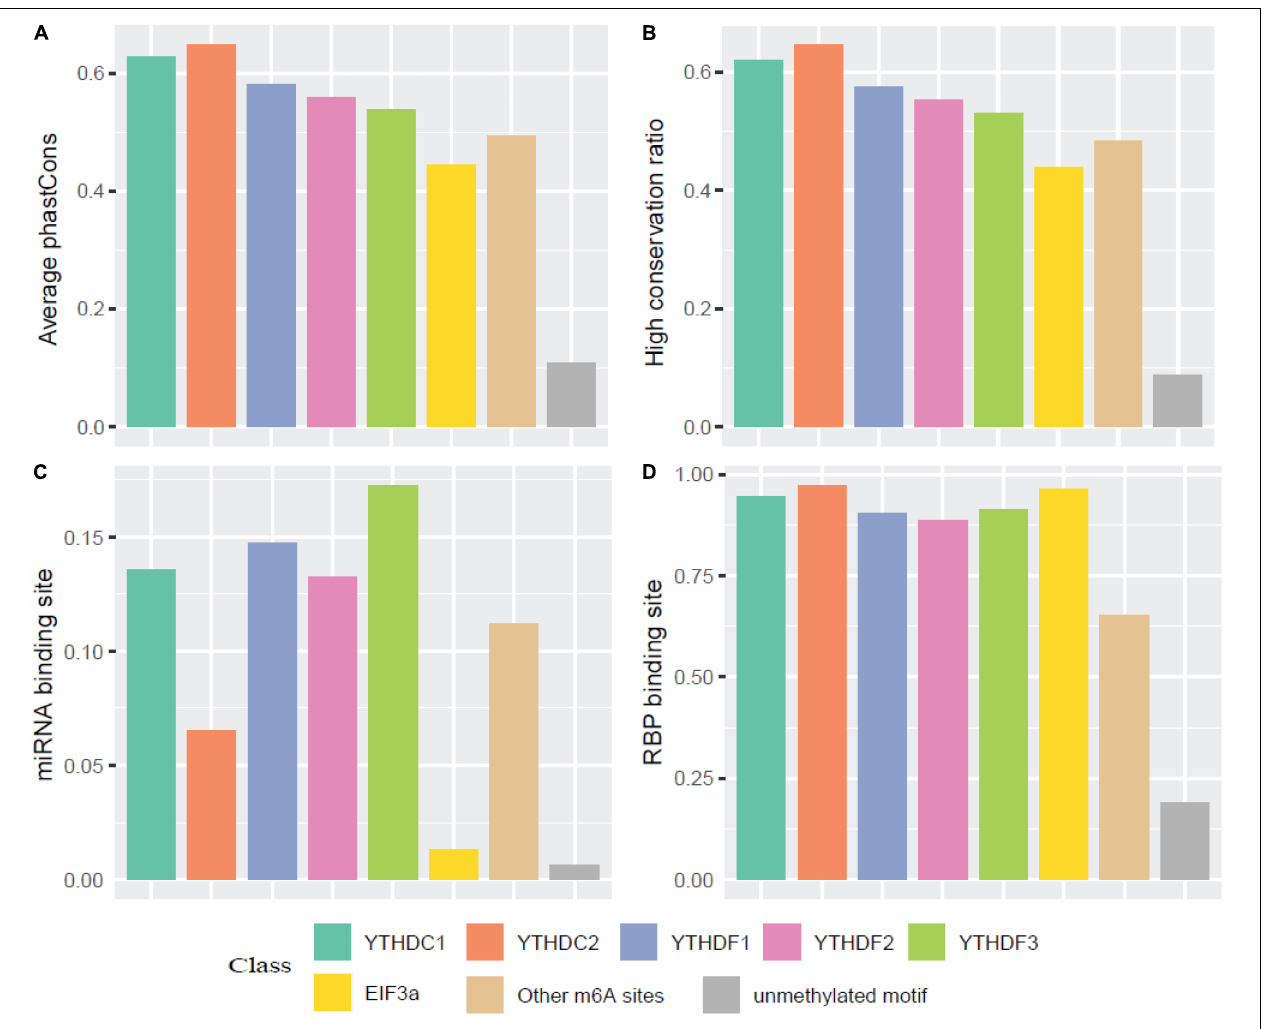
FIGURE 4 | Conservation analysis of the m 6 A sites targeted by different readers. (A) Average phastCons; (B) High conservation ratio; (C) Frequency of miRNA binding site among the targets of six m 6 A readers; (D) Frequency of RBP binding site among the targets of six m 6 A readers.